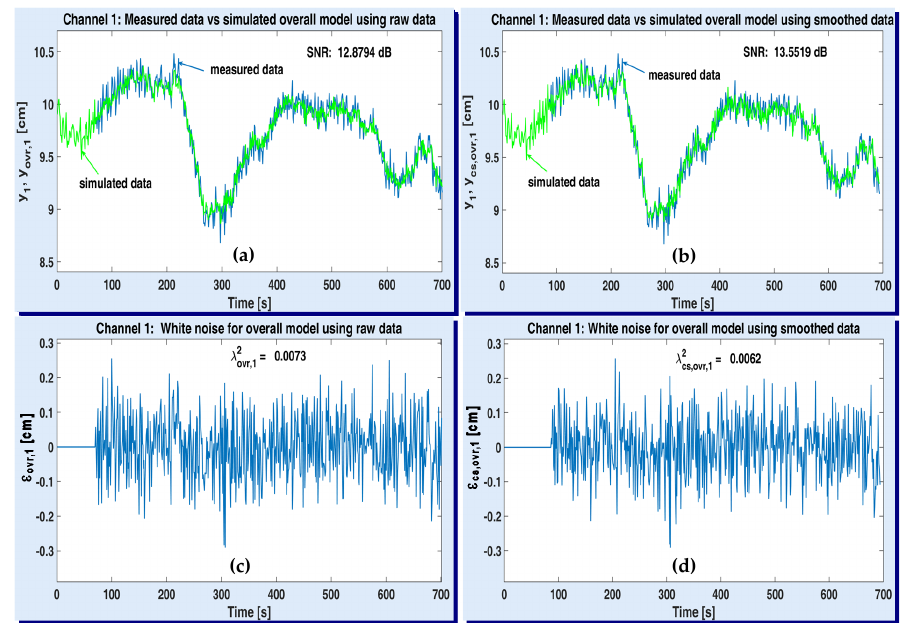
Figure 13. Performance of the optimal overall MISO model associated to ASTANK2 installation, on channel 1: measured versus simulated outputs with raw data ( a ) and smoothed data ( b ); estimated white noise from raw data ( c ) and smoothed data ( d ).